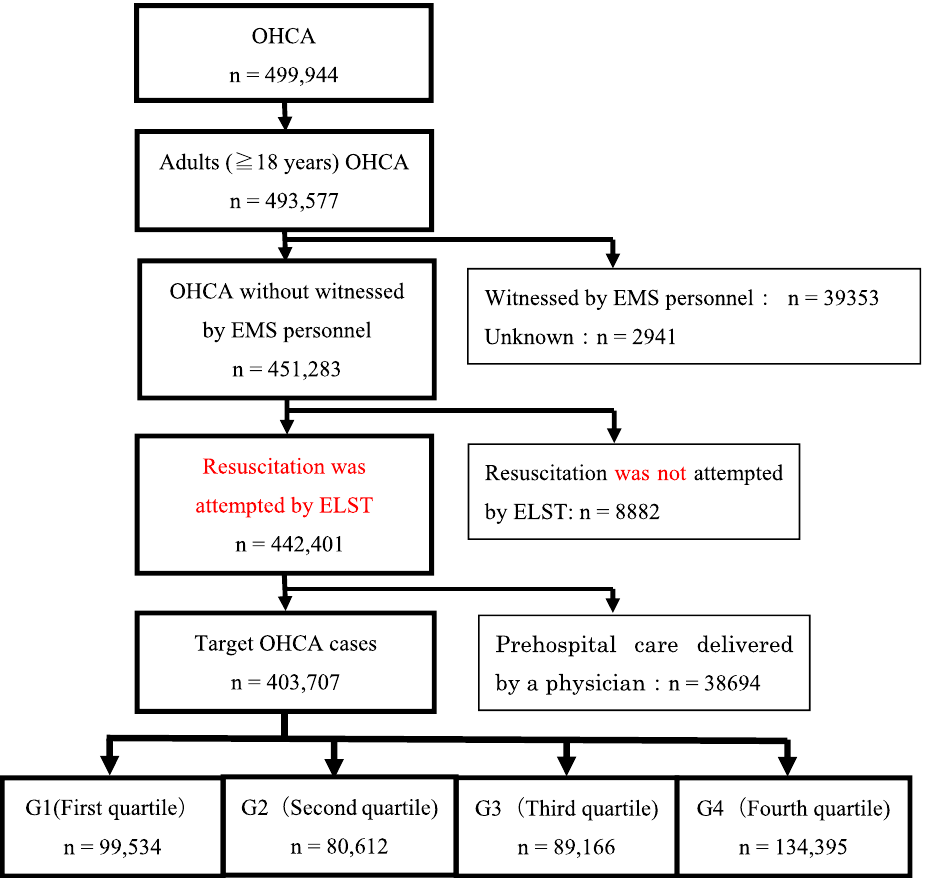
Figure 3. Flow of out-of-hospital cardiac arrest patients from January 1, 2014 to December 31, 2017 in the All-Japan Utstein Registry. *Cases grouped by the frequency of pre-hospital Advanced Airway Management approach by prefecture (Quartile G1 to